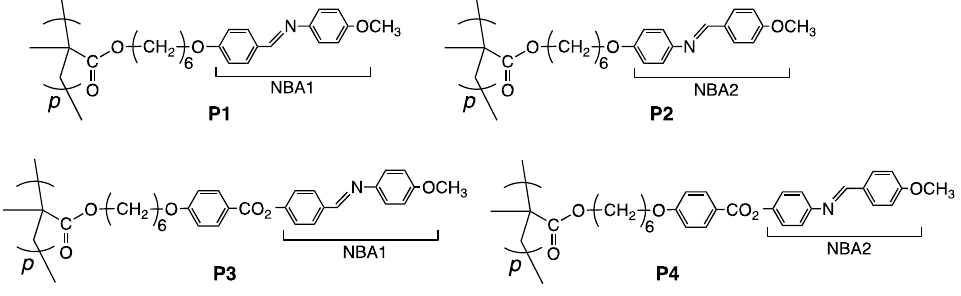
Figure 1. Chemical structures of LCPs containing NBA moieties.